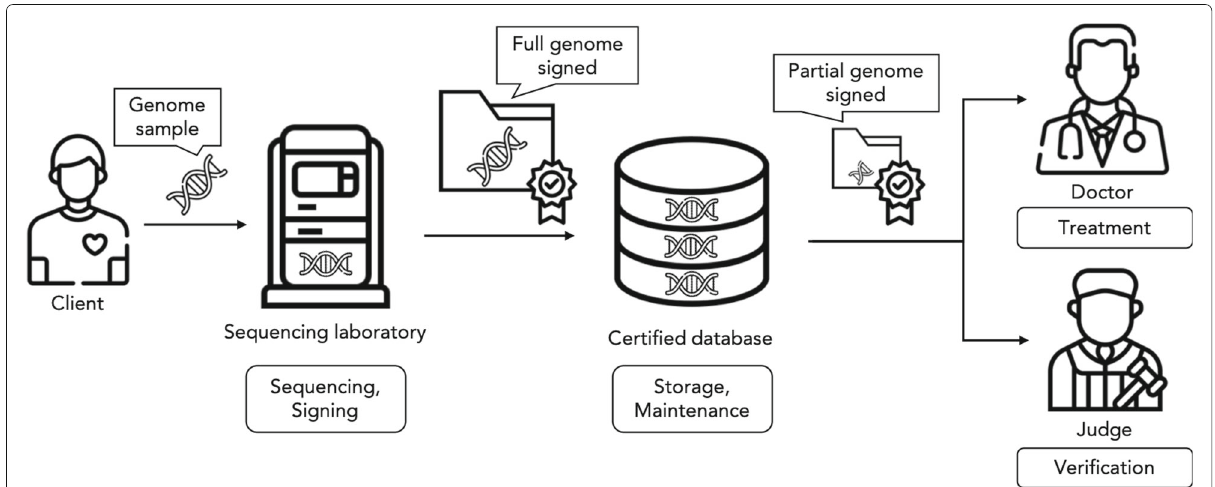
Fig. 1 Overview of the application scenario for our protection scheme